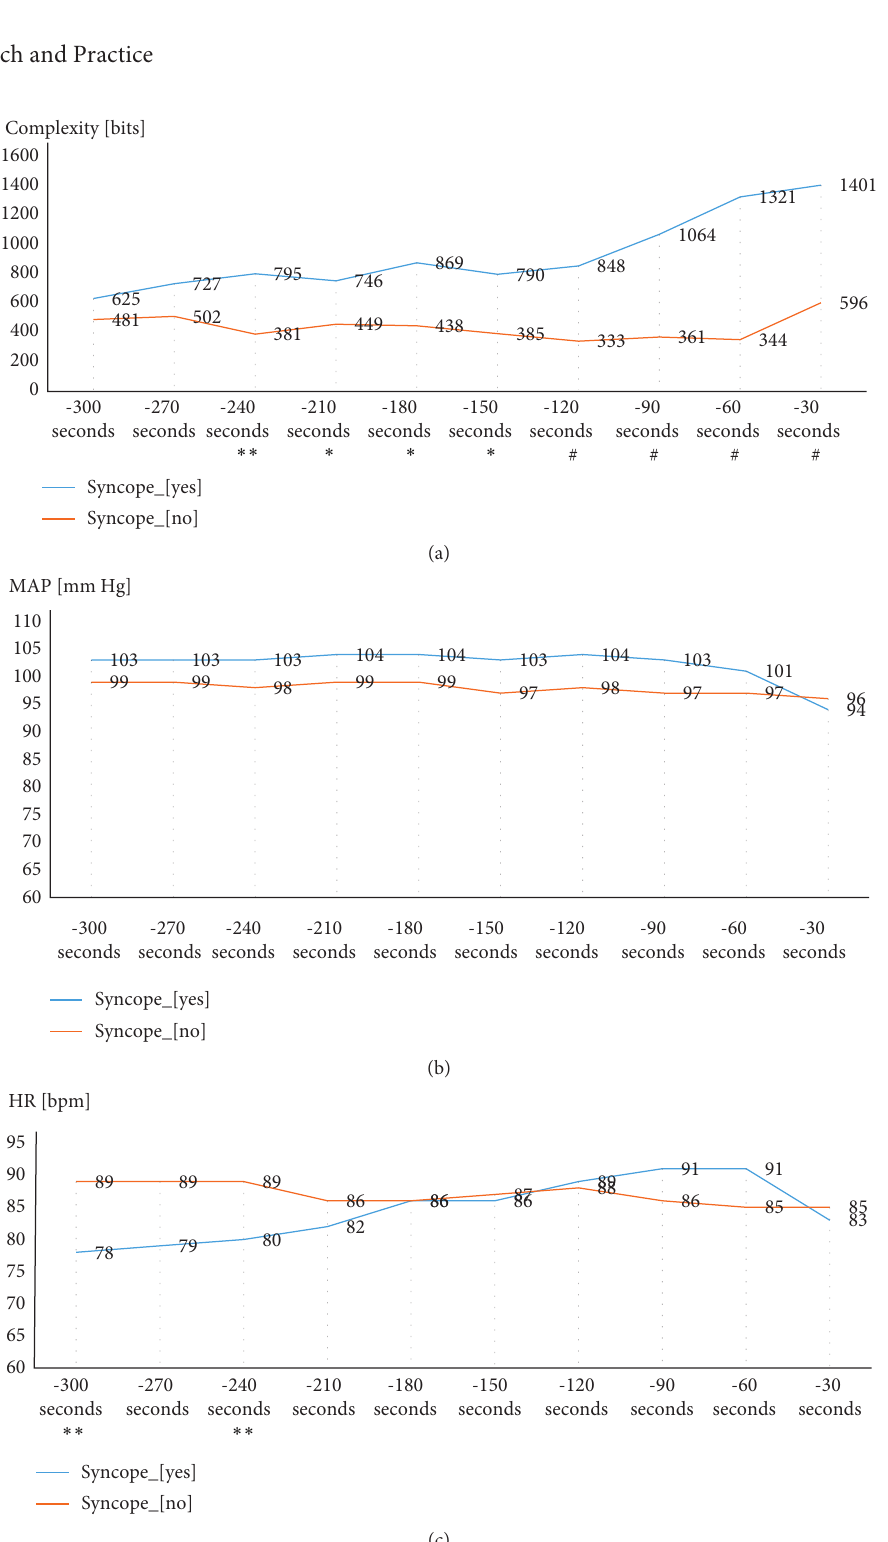
Figure 3: Intergroup comparison of complexity, mean arterial pressure (MAP), and heart rate (HR) values in the last 300s before the termination of HUTT ( ∗ p < 0 . 05, ∗∗ p < 0 . 01, # p < 0 .